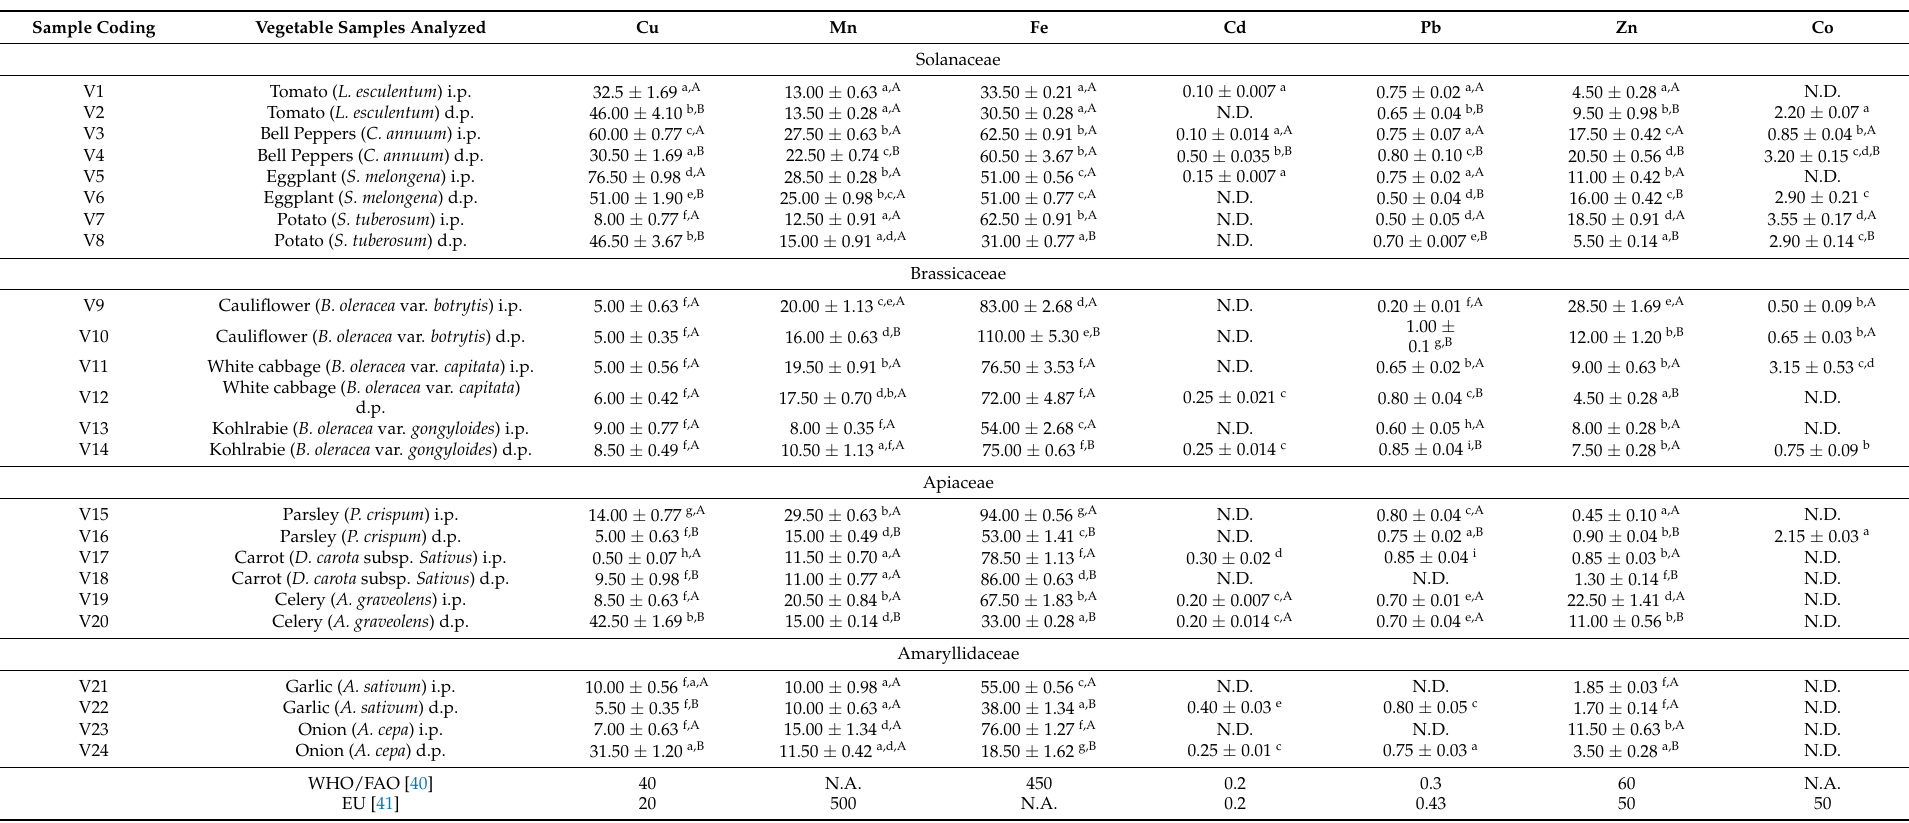
Table 2. Trace-element content in the 24 vegetable samples of different botanical families with permissible limits (EU and WHO/FAO) ( µ g · g − 1 dry weight, mean ±